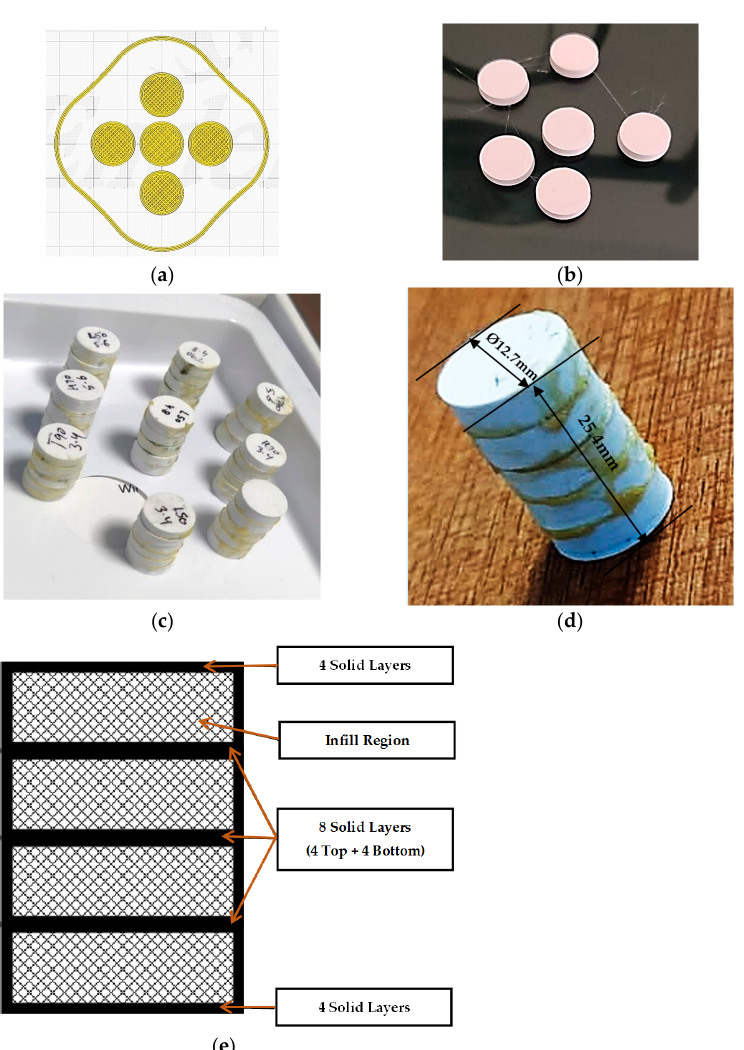
Figure 1. ( a ) 3D Sliced image, ( b ) real-time images of 3D printed specimens, ( c ) nine samples by joining multiple discs (standard size of 12.7 × 25.4 mm) as per DOE, ( d ) Single sample of PLA with dimensional detail, and ( e ) Schematic of solid and infill layers in the laminated specimen having 4 discs. Table 1. Properties of PLA used in the current study according to the manufacturer. Properties Values Tensile Strength 16 – 80 MPa Modulus of elasticity